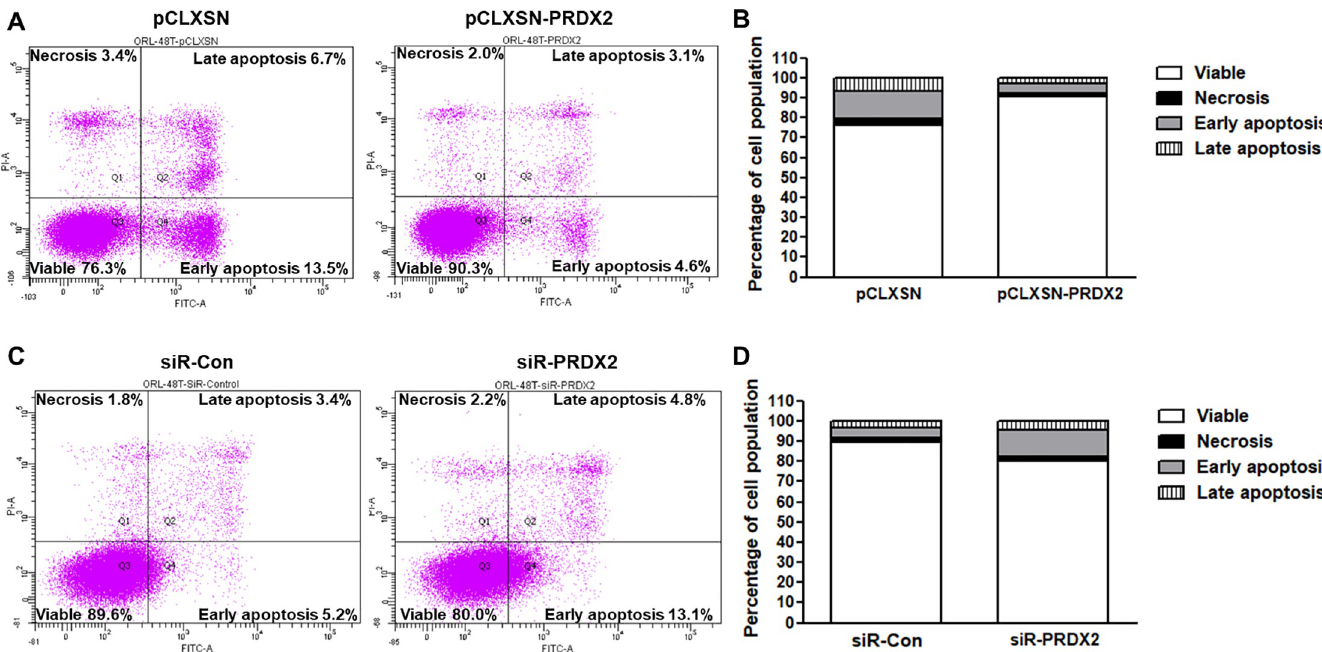
Fig 6. PRDX2-overexpressing and siR-PRDX2 knockdown ORL-48T cells in apoptosis analysis. ORL-48T transduced with retrovirus-carrying pCLXSN or pCLXSN-PRDX2 (A and B) and transfected with siRNA-Control (siR-Con) and siR-PRDX2 (C and D) were maintained in DMEM/F12 medium supplemented with 2.5% FBS for 72 hours. The analysis of apoptosis in pCLXSN-PRDX2-transduced (A and B) and siR-PRDX2-transfected (C and D) ORL-48T cells was performed using flow cytometry with an apoptosis kit.